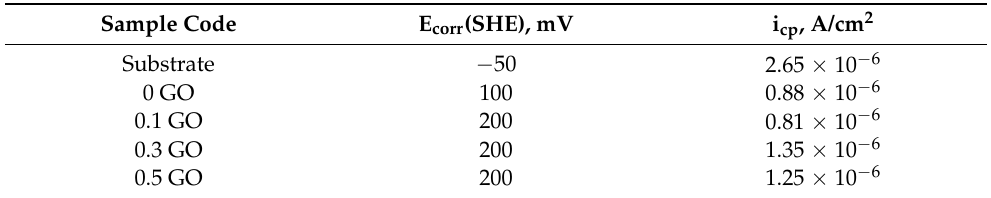
Table 4. Results of potentiodynamic polarization measurements; E corr —corrosion potential (SHE); i cp —anode current density of complete passivation at potential of 900 mV